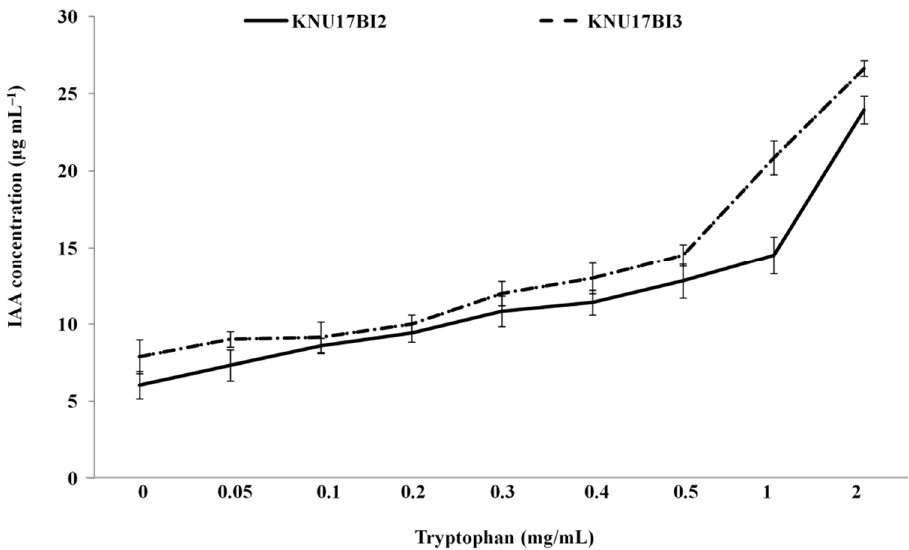
Figure 4. Effect of L -tryptophan concentration on indole acetic acid (IAA) production by strain KNU17BI2 and strain KNU17BI3 assessed after three days of incubation. The vertical bars indicate the standard error of three replications.